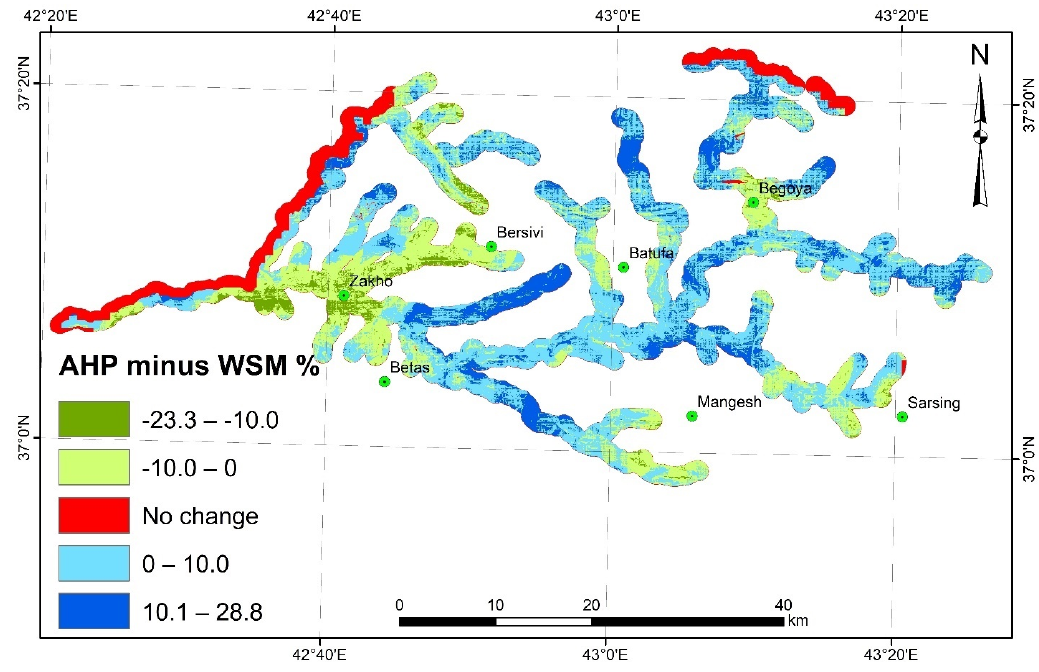
Figure 13. Difference (AHP minus WSM) map. Figure 13. Di ff erence (AHP minus WSM)